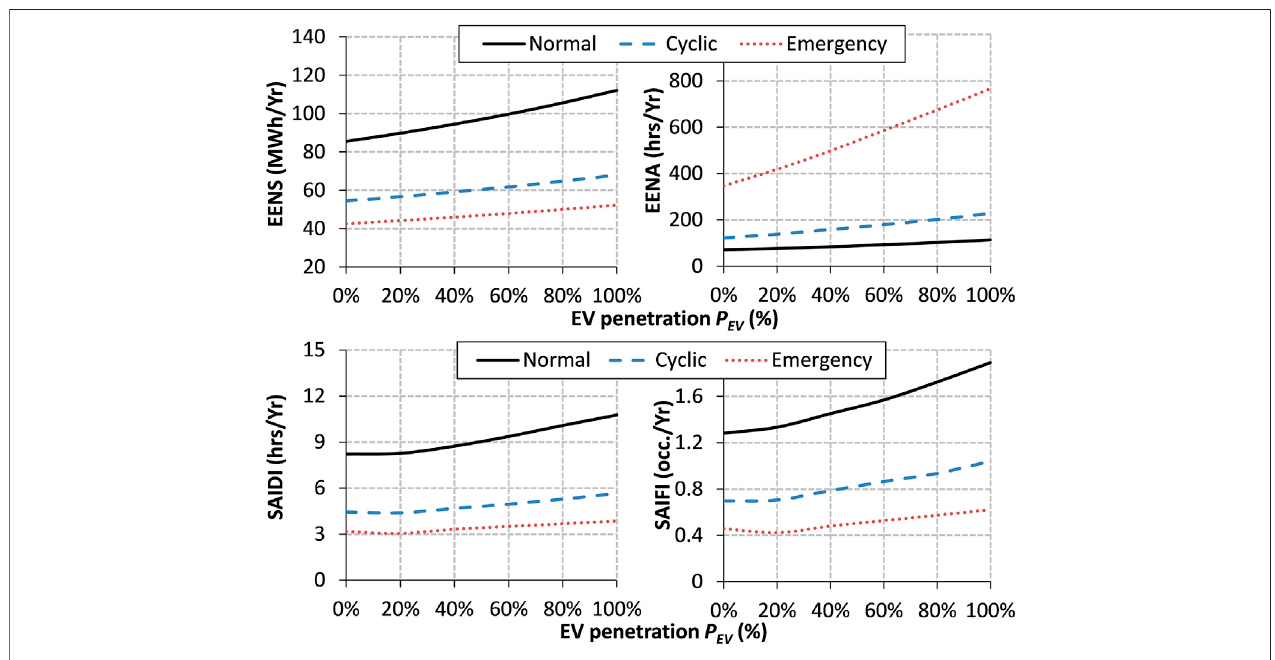
FIGURE 5 | EENS, EENA, SAIDI and SAIFI output of Sc-4 when utilizing normal, cyclic and emergency ratings.